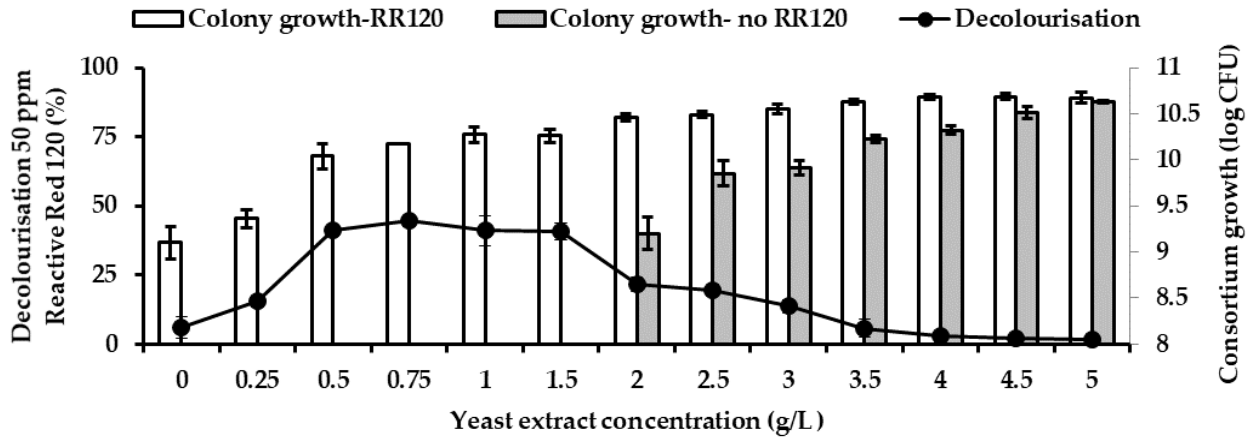
Figure 8. Effect of different yeast extract concentration on consortium JR3′s ability to decolourise 50 ppm Reactive Red 120. Data represent mean ± SD, n = 3.